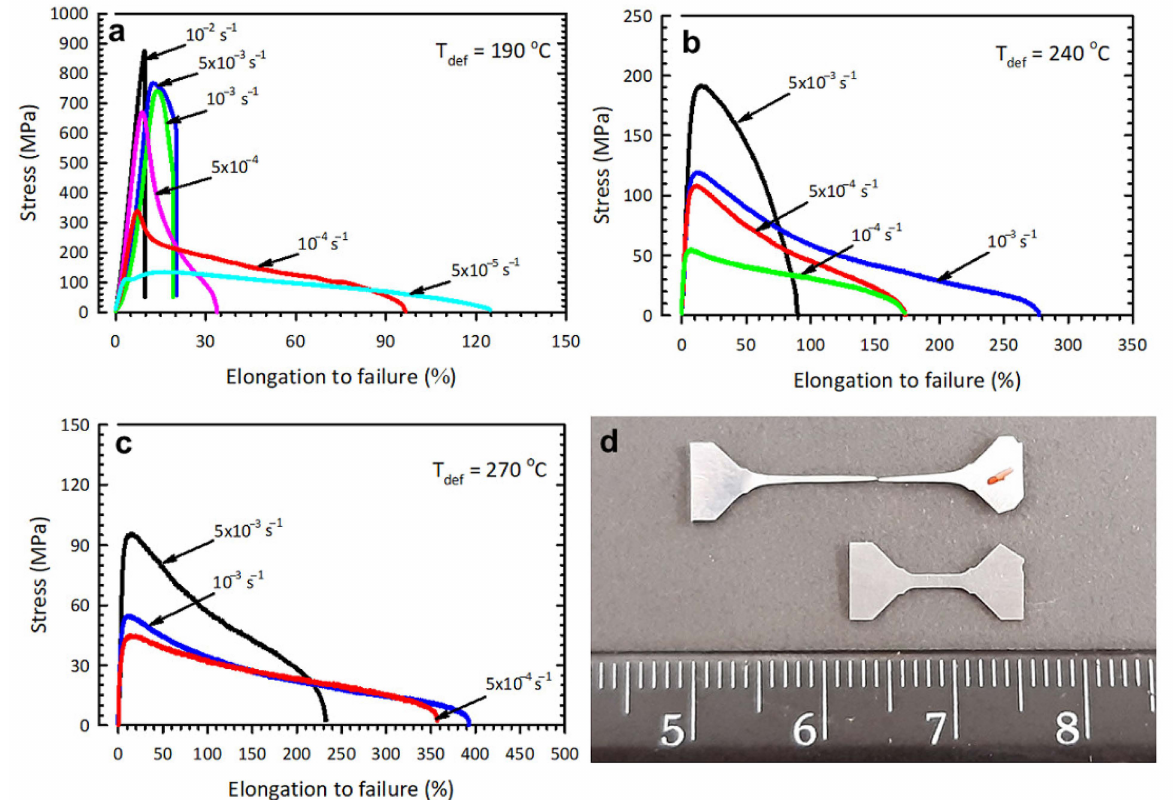
Figure 4. Engineering tensile curves for the UFG Al 2024 alloy subjected to tensile testing at: ( a ) 190, ( b ) 240, ( c ) 270 ◦ C and ( d ) a sample after the test at a temperature of 270 ◦ C and a strain rate of 10 − 3 s − 1 .